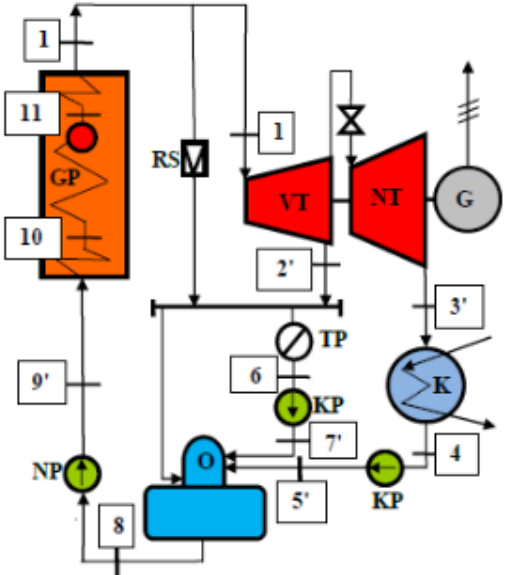
Fig. 2. Steam cogeneration plant with the condensation turbine and steam subtraction: